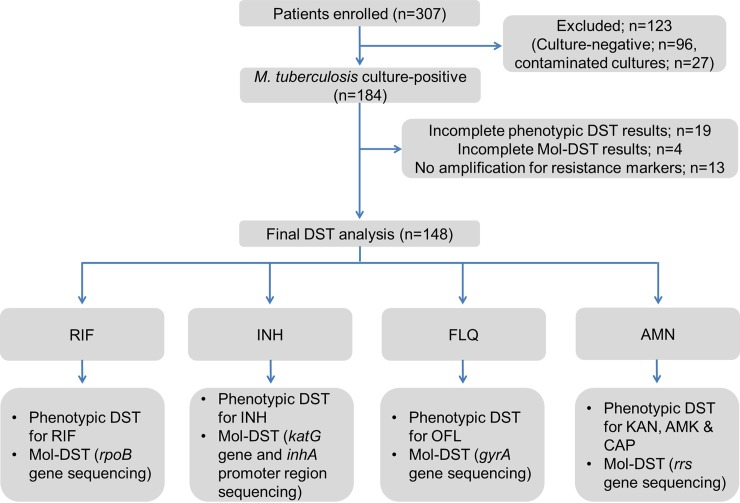
Participant enrolment and testing in ‘TB concentration & transport’ kit and ‘TB DNA extraction’ kit evaluation study.